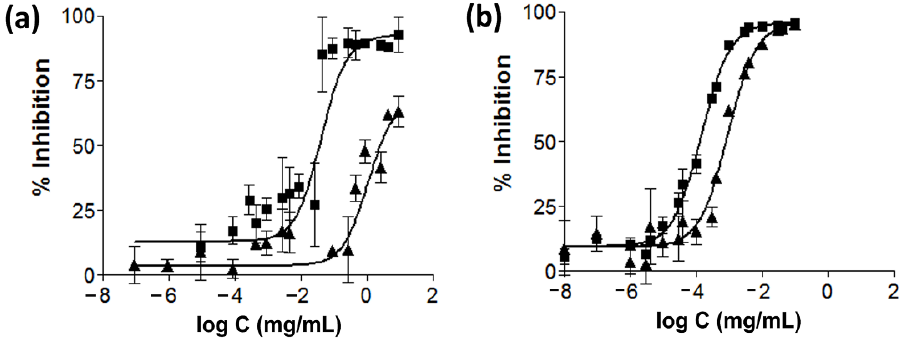
Figure 1. Dose–response curves for anti-AChE ( ■ ) and anti-BChE ( ▲ ) activities of AGO ( a ) and galantamine hydrobromide ( b ).